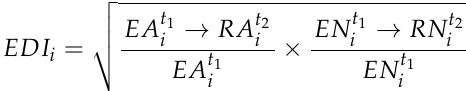
Figure 3. Patterns of